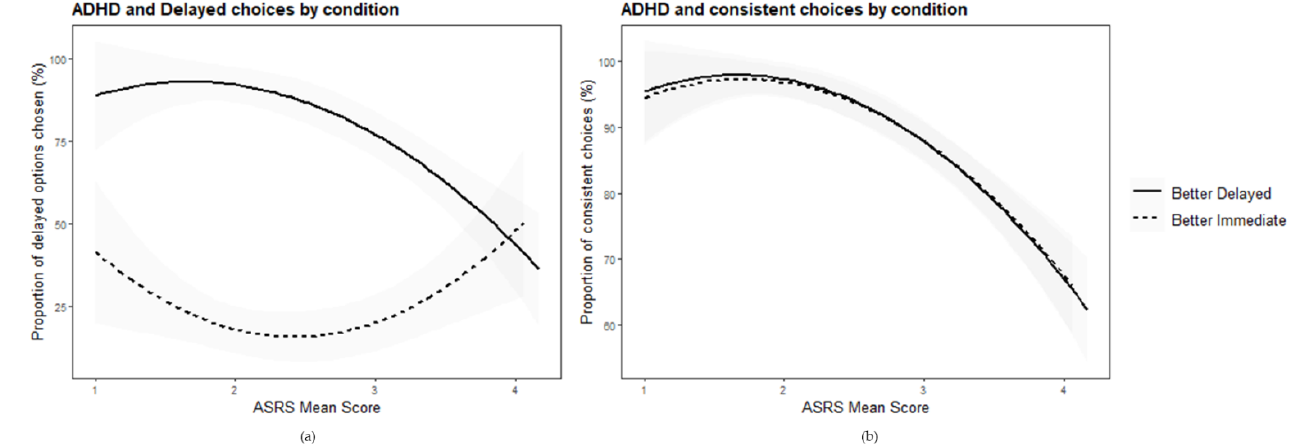
Figure 1. ( a ) Regressions (quadratic term) of the relationship between the level of ADHD symptoms (ASRS (ADHD Self Report Scale) mean score) and the proportion of choices to wait for the two conditions: delay is better (solid line), and immediate is better (dashed line; R² = 0.30; R² = 0.10, respectively). ( b ) Regressions (quadratic term) of the relationship between the level of ADHD symptoms (ASRS mean score) and the proportion of consistent choices for the two conditions: delay is better (solid line), and immediate is better (dashed line; R² = 0.44; R² = 0.43, respectively).